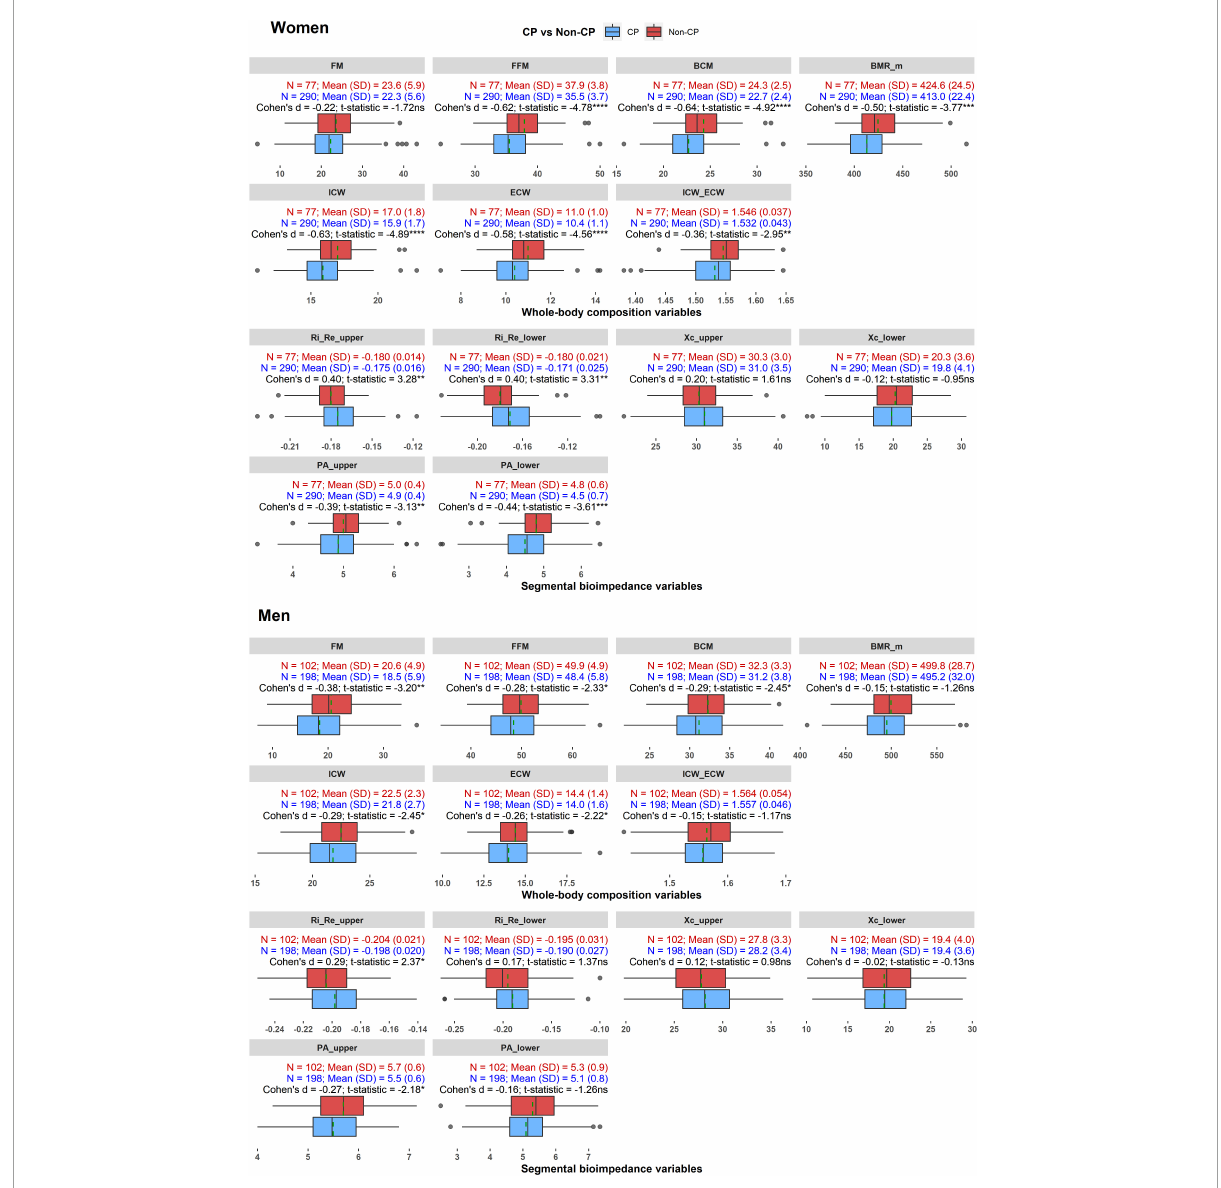
FIGURE3 The distributions and comparisons of whole-body composition and segmental bioimpedance variables in the CP and non-CP groups in women and men. * p < 0.05, ** p < 0.01, *** p < 0.001, **** p < 0.0001, ns: not significant. Dashed green line indicates mean value of each variable in each